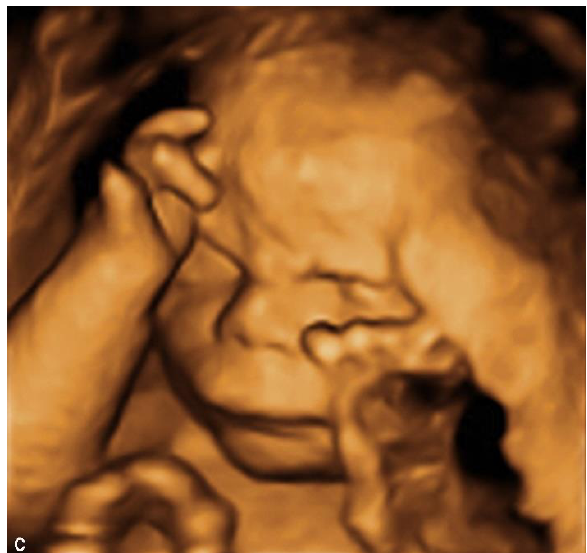
Figure 1. Ultrasound examination of the fetal face in a CDLS case with classical phenotype: ( A ) 2D image of the fetal profile at 29 w of gestation, showing mild micrognathia/retrognathia; abnormal philtrum; depressed nasal bridge; ( B ) Volume reconstruction of the fetal face at 29 w of gestation; ( C ) Volume reconstruction of the fetal face at 34w of gestation.